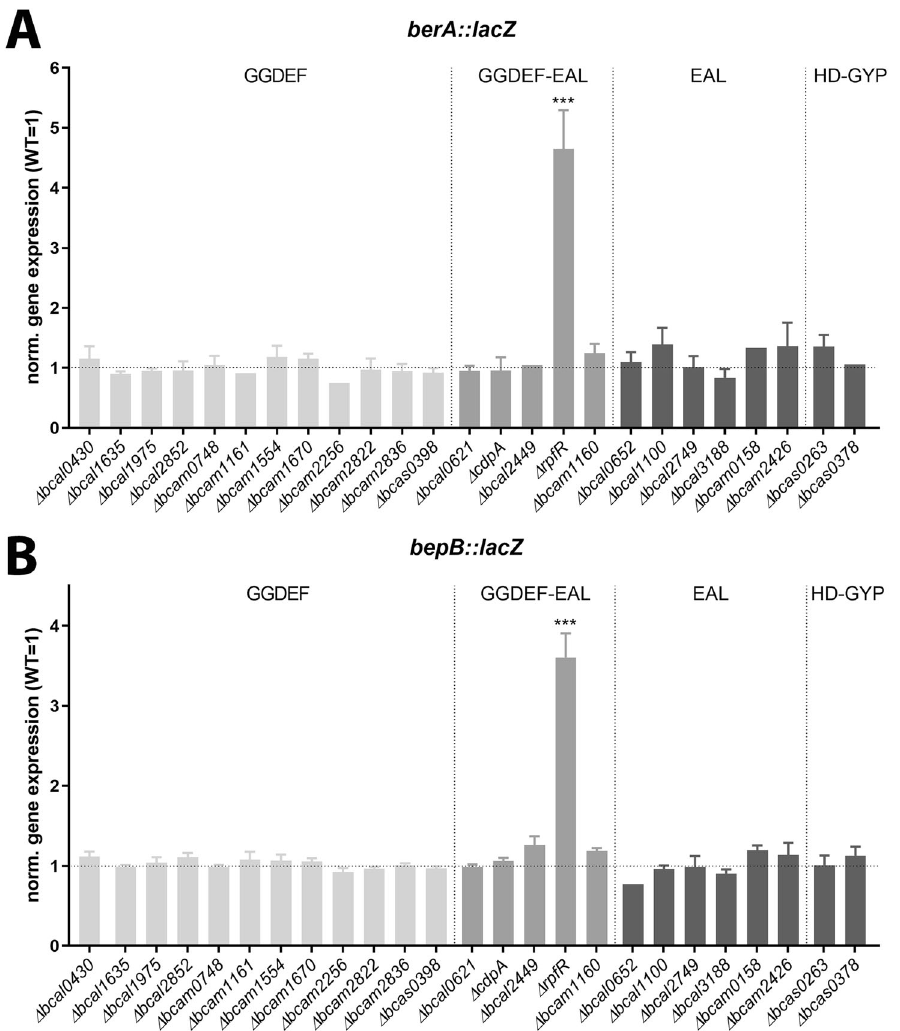
Fig. 4 Expression of berA :: lacZ (A) and bepB :: lacZ (B) reporter genes in B. cenocepacia DGC/PDE mutant cultures. Light gray bars represent mutants of genes encoding GGDEF-only proteins, gray bars represent mutants of GGDEF-EAL proteins, whereas dark gray bars represent mutants of EAL-only and HD-GYP proteins. β -galactosidase activities are normalized to the level of the wild-type strain. The data represent the mean and standard deviations of three replicates grown in AB minimal media using glucose as the carbon source. The signi fi cance levels, as determined using a one-way ANOVA, of the difference between the wild type and mutant strains are indicated above the bars; *** P < 0.001, no stars indicate no signi fi cant